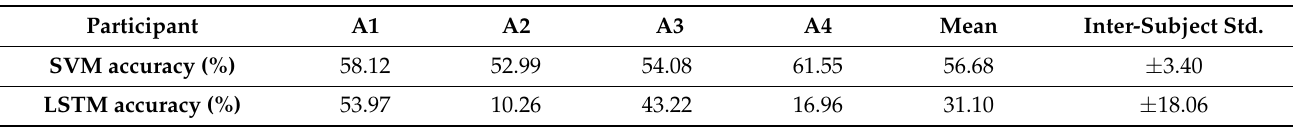
Table 11. Mean Leave-One-Subject-Out (LOSO) accuracies of each of the four lower limb-amputated subjects, using models trained only on lower limb amputated